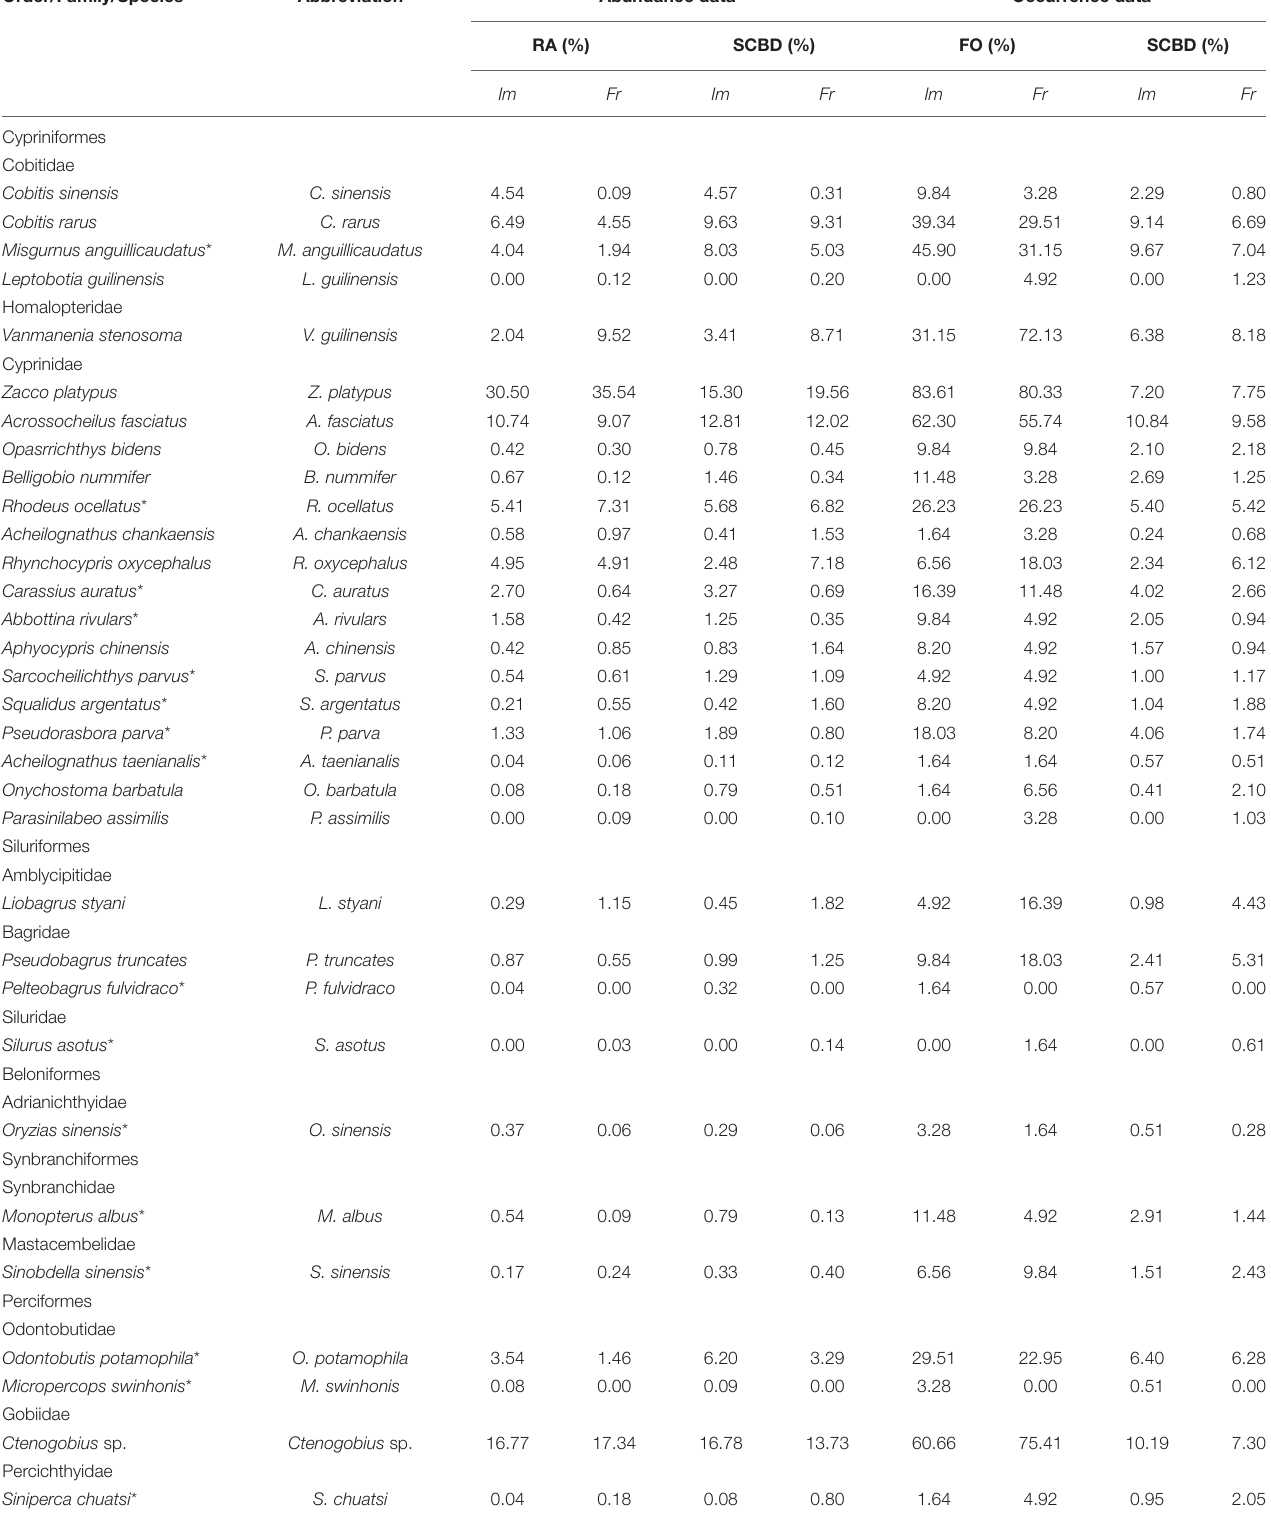
TABLE 1 | Species compositions, occurrence of frequency ( FO ), and relative abundance ( RA ) of fishes collected in impoundments ( Im ) and free-flowing segments ( Fr ). Order/Family/Species Abbreviation Abundance